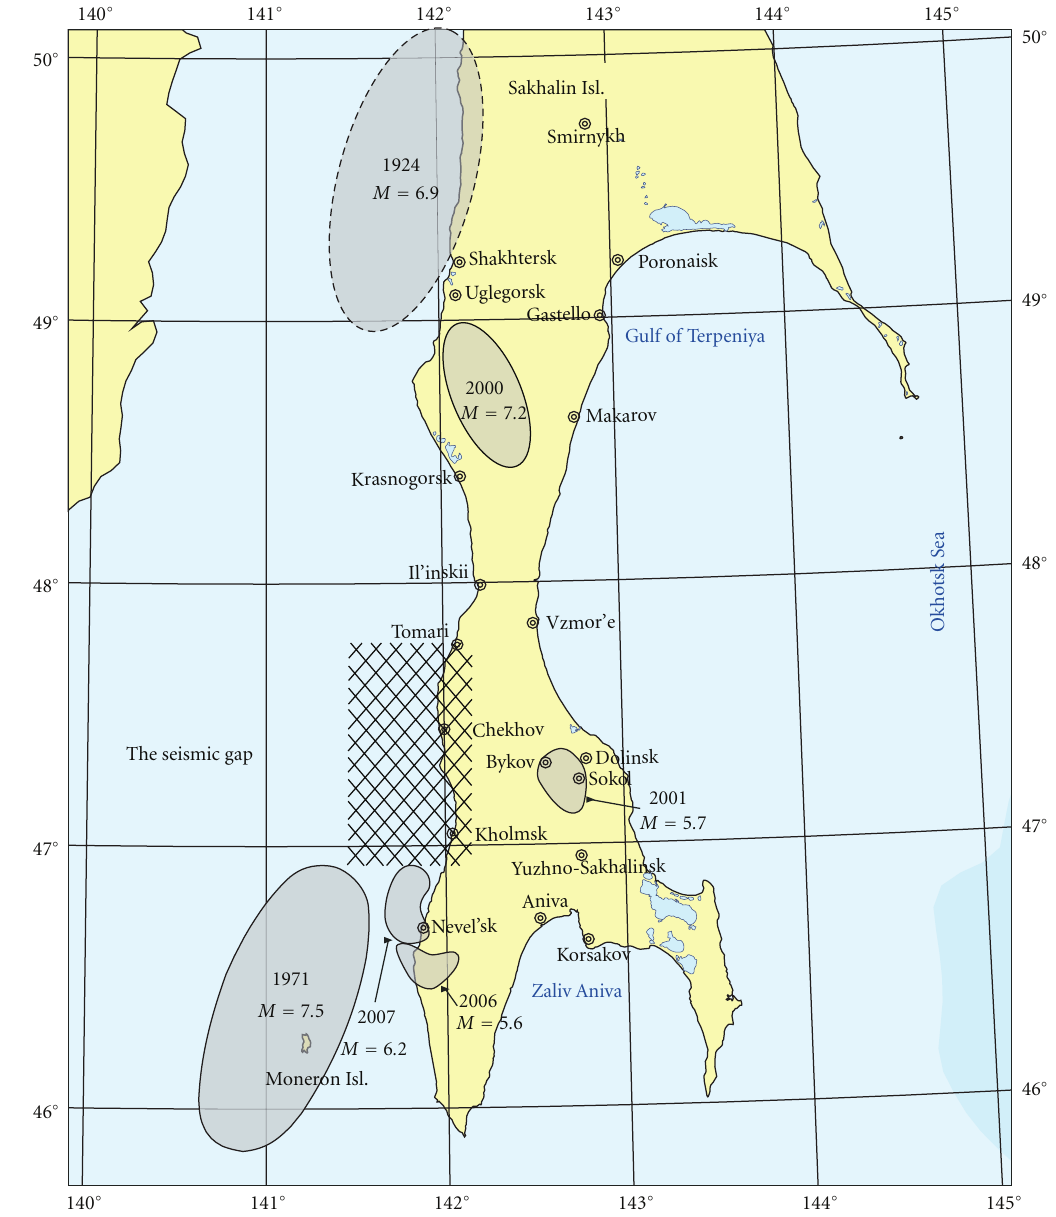
Figure 5: Sources of large earthquakes at the western coast of Sakhalin Island (grey ovals) and the approximate location of the seismic gap (hatched